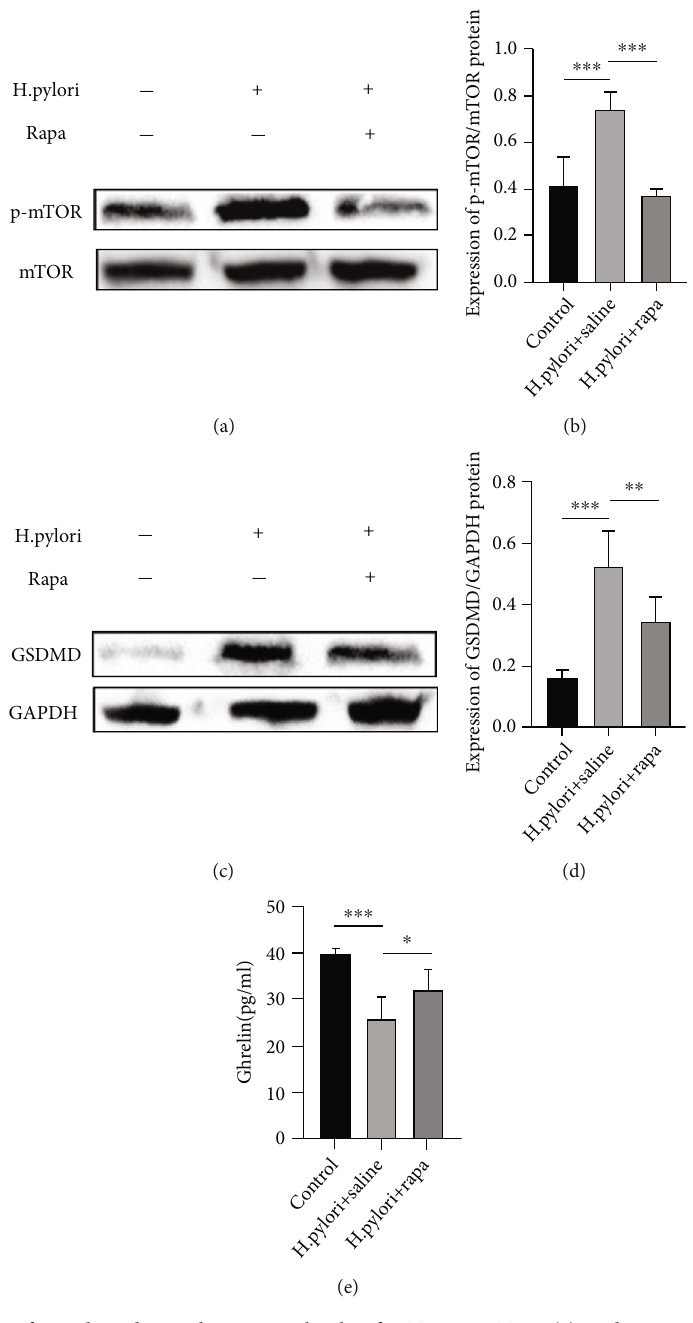
Figure 5: Western blot was performed to detect the protein levels of mTOR/p-mTOR (a) and GSDMD (c) expression. The protein expressions of p-mTOR (b) and GSDMD (d) were measured by densitometry and normalized to GAPDH. (e) The ELISA kits detected the levels of ghrelin. ∗ P < 0 : 05, ∗∗ P < 0 : 01, and ∗∗∗ P < 0 : 001 versus respective